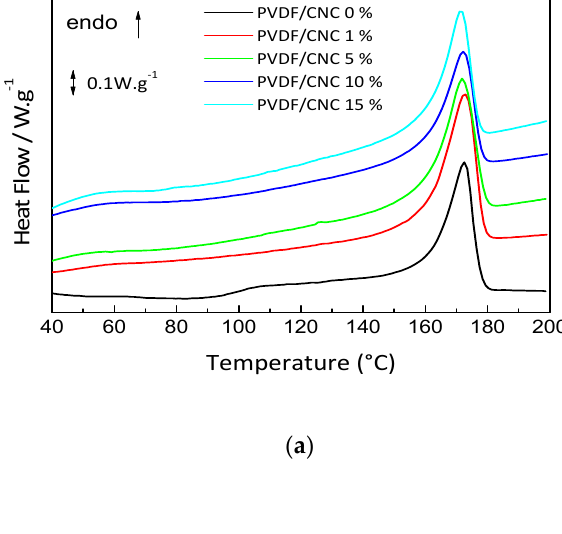
Table 3. Mechanical parameters for the prepared PVDF/CNC nanocomposites. SampleN